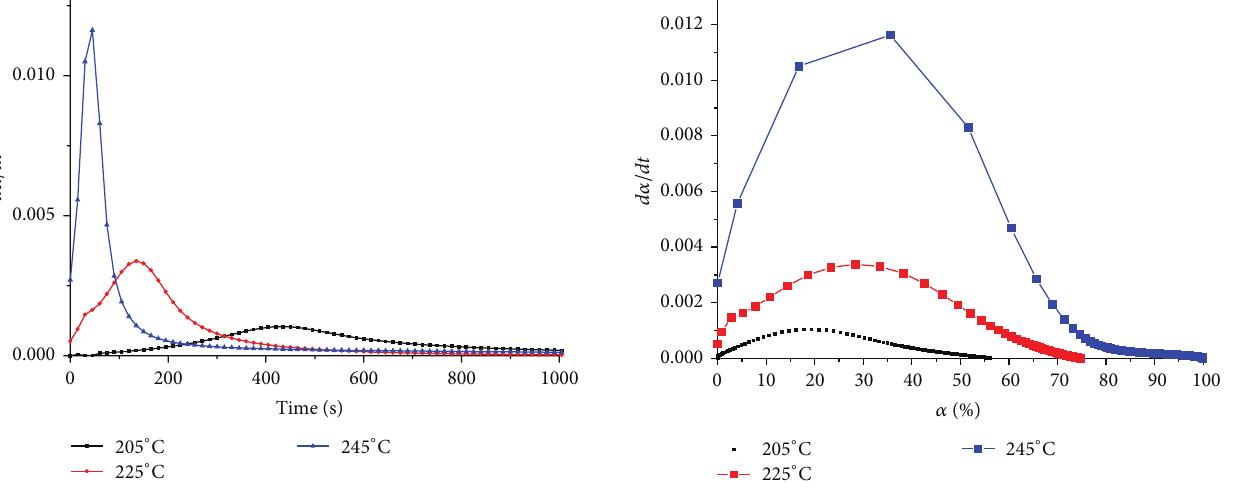
Figure 6: 𝑑𝛼/𝑑𝑡 versus conversion of BZ homopolymer in isother- mal